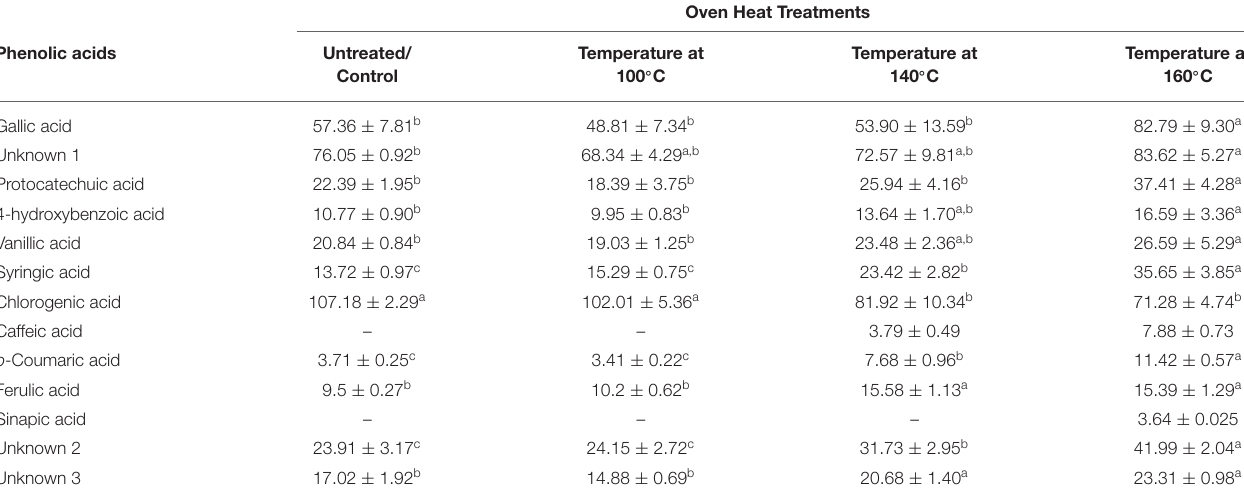
TABLE 1 | Impact of heat treatments of defatted BSG meal (DW) on individual phenolic acid content ( µ g/g sample) analyzed by